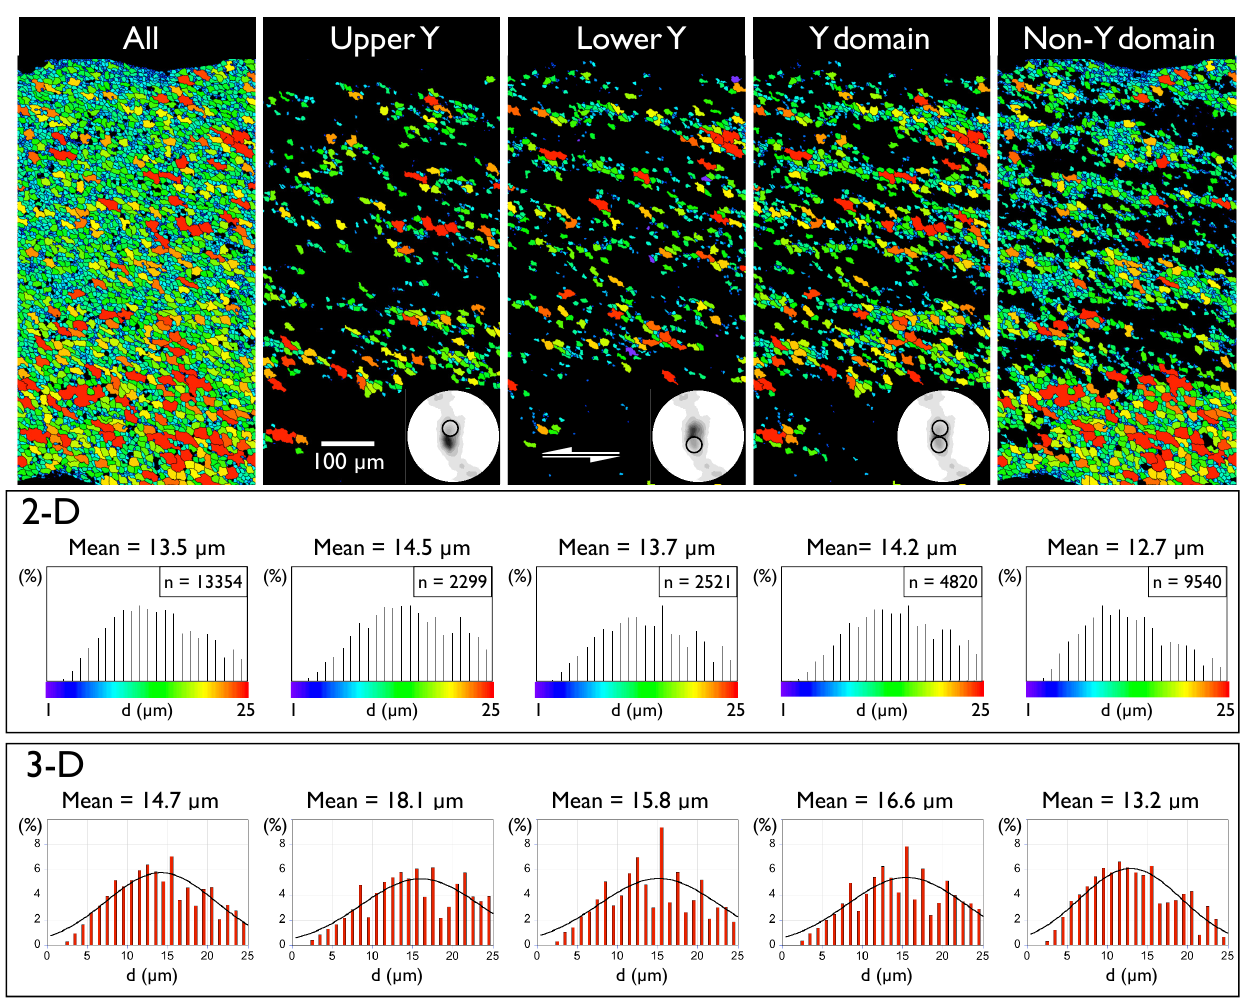
Figure 8. Grain size in texture domain. Grain size maps of sample w935 (regime 3) are shown. From left to right: all grains, grains in the upper and lower Y subdomains (as indicated by the inset pole figures), in the whole Y domain, and for c -axis orientations outside the Y domain. All domain maps are derived for c -axis orientations within a 30 ◦ cone (15 ◦ opening angle) with respect to the central orientation. Scale bar and shear sense apply to all. Below the maps are area-weighted distributions of 2-D grain size (gray value histogram of grain size map; see Heilbronner and Barrett, 2014, chap. 12) with the mean indicated above, and histograms of StripStar-calculated volume fractions of the 3-D grain size with the mean ( = mode) of the Gauss fit. Note that the grain size in the Y domains is larger than in the non-Y domain, while the difference between the upper and lower Y subdomain is not